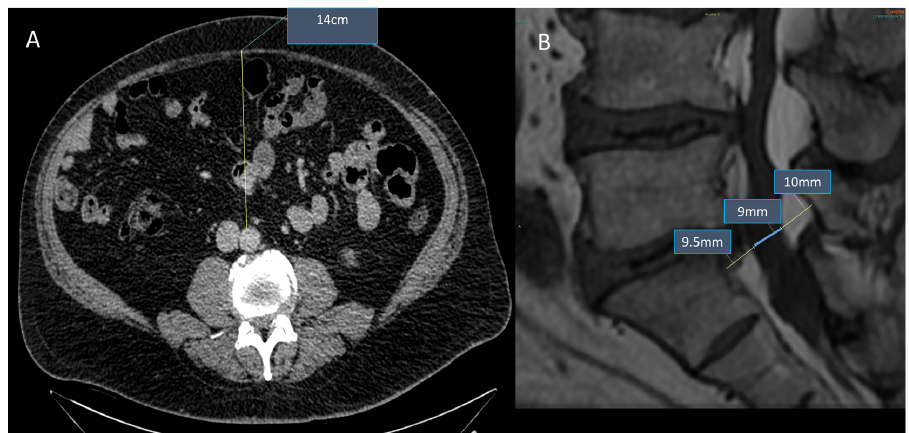
Figure 1. Obese patient (45 years old, male, BMI = 31 kg/m 2 , dyslipidemia). Association between SEL and visceral fat deposition: CT of the abdomen (Panel A ) reveals increased visceral fat deposition (AP diameter 14 cm), while lumbosacral MRI sagittal T1w (Panel B ) reveals SEL grade 2: moderate (dural-sac/epidural fat index = 0.46).